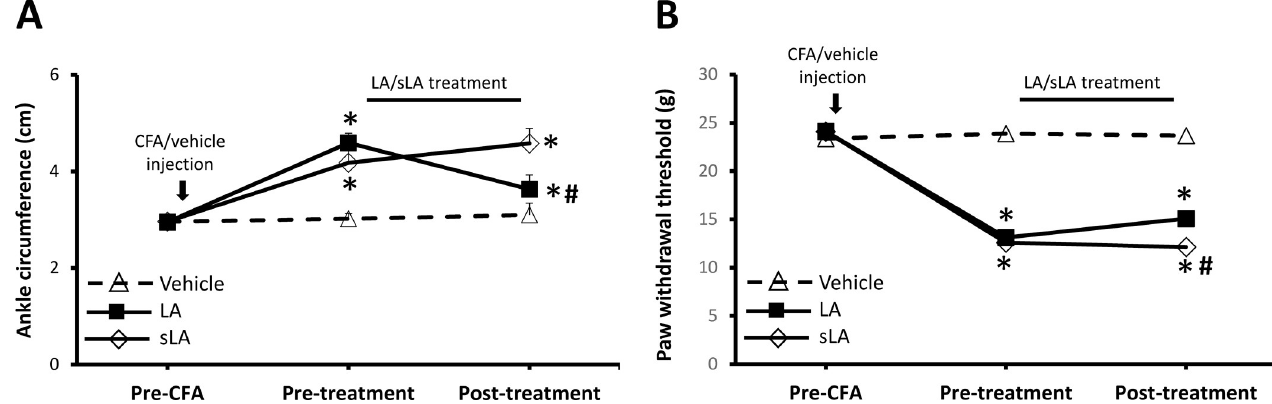
Fig 2. Development of ankle circumference (A) and pain withdrawal threshold (B) in vehicle injection, CFA-induced arthritic rats treated with laser acupuncture (LA) and sham-operated laser acupuncture (sLA) at timepoints of before CFA injection (Pre-CFA), before and after treatments (Pre- treatment and Post-treatment) . Values are means ± SD. � indicates a significant change in the parameter assessed (P < 0.05), when values are compared with vehicle control values. # indicates a significant change in the parameter assessed (P < 0.05), when values are compared with sLA values.